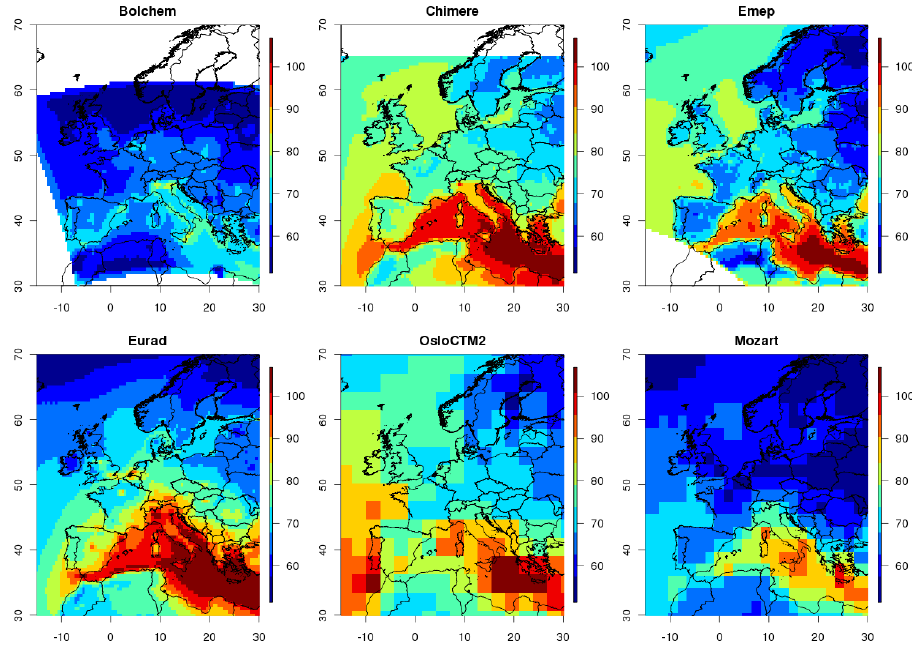
Figure 5 : Average modelled Ox (µg /m3) [=NO 2 + O 3 ] fields over 10 years for each model. Fig. 5. Average modelled O x (µgm − 3 ) [=NO 2 +O 3 ] fields over 10yr for each model.